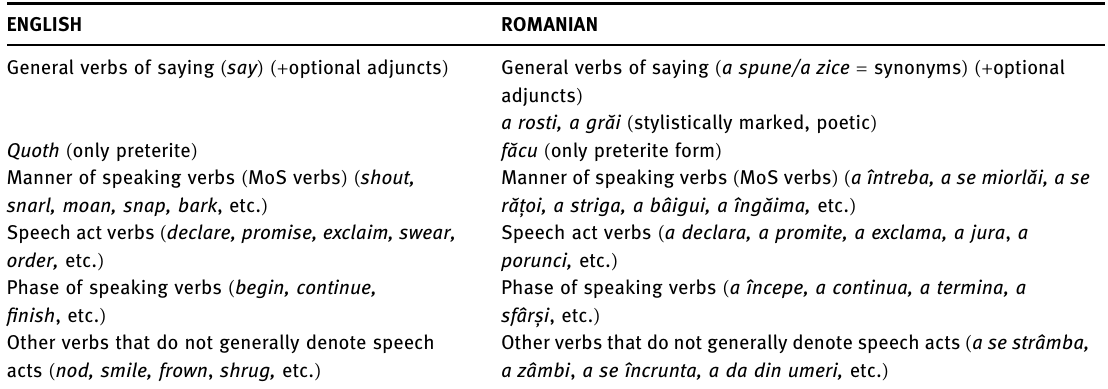
Table 1: Types of quoting